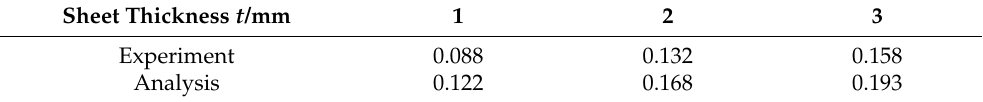
Figure 17. Effect of sheet thickness on appearance of the rolled sheet metal. Table 8. Average specific twisted angle β ( δ = 20 mm, ϕ = 20 ◦ ). Unit: °/mm.